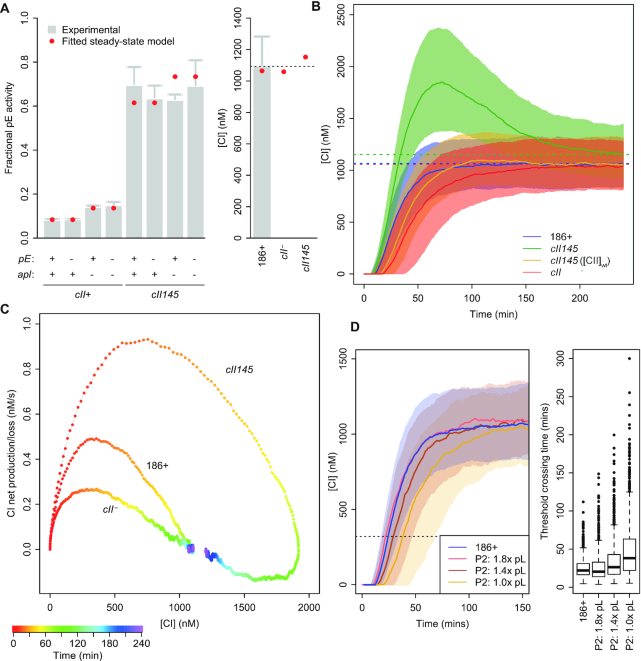
Mathematical modelling of the 186 genetic switch. (A) Translation initiation rate parameters of the model were optimised to fit (red circles) the measured pE activity of switch variants (left panel) and lysogenic CI concentrations (right panel). Experimental data is the same as that in Figures 6A and 5A; a fractional pE activity of 1 corresponds to 1635 LacZ units. (B) Plot of the evolution of median CI concentration over time in variants of the 186 genetic switch (n = 3000 simulations per curve; shaded area is the interquartile range). Rapidly rising CI concentrations in the stable cII145 variant explain the high frequency of lysogeny phenotype. Slow increases in and equilibration of CI concentrations in other cII145 derivatives relative to cII+ suggest a low frequency phenotype for these variants. Dotted lines indicate final lysogenic levels of CI. (C) Plot of CI concentration vs net CI production (n = 3000 simulations per curve). High maximal CI production in cII145 provide an explanation for the impaired induction phenotype of this variant. (D) cII– gene network variants can achieve a similar evolution of CI concentrations to that of the wild type 186 network, in the case where pL activity is stronger and CI repression of pL is enhanced. Each curve shows median CI concentration from n = 3000 simulations. The box plots on the right of panel D show the distribution of times at which [CI] = 320nM was reached in the simulations. This [CI] threshold represents 100× the EC50 for CI repression of pR.